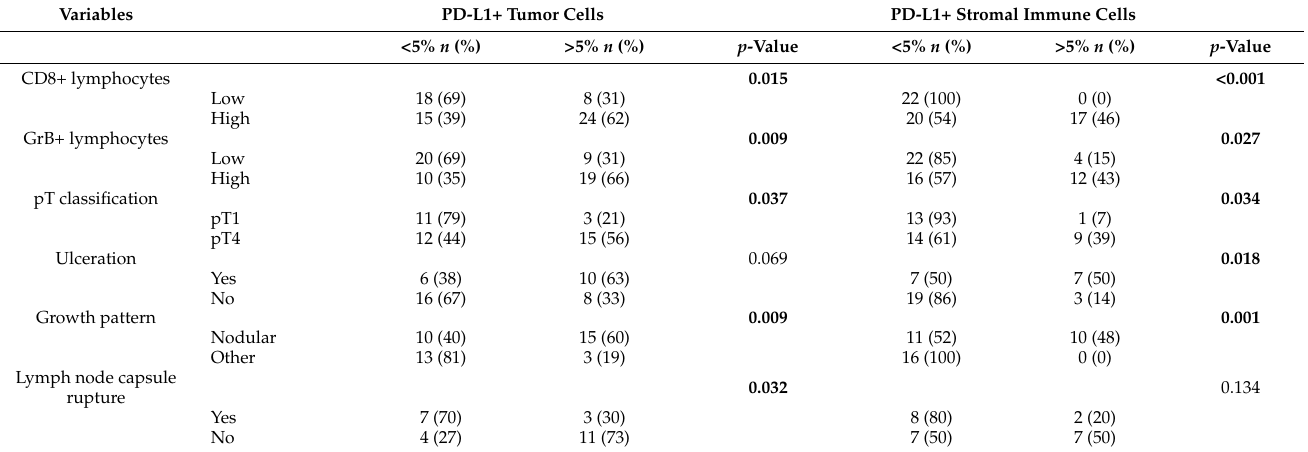
Table 6. Associations of PD-L1+ tumor and stromal immune cells with CD8+ and GrB+ lymphocytes and clinicopathological parameters. pT = pathological tumor